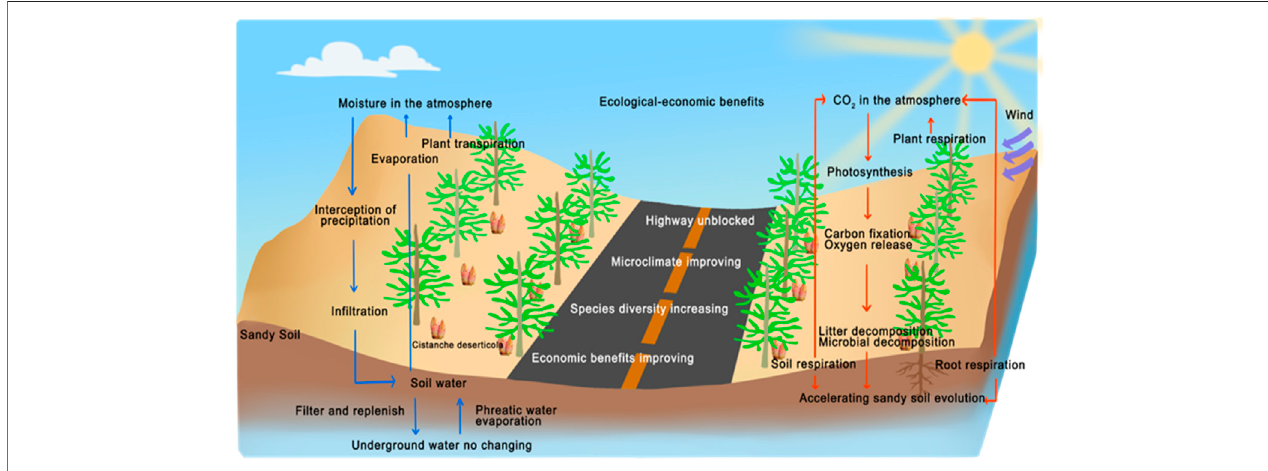
FIGURE 12 | Conceptual diagram of sustainable development of the man-made ecosystem in the Taklamakan Desert.